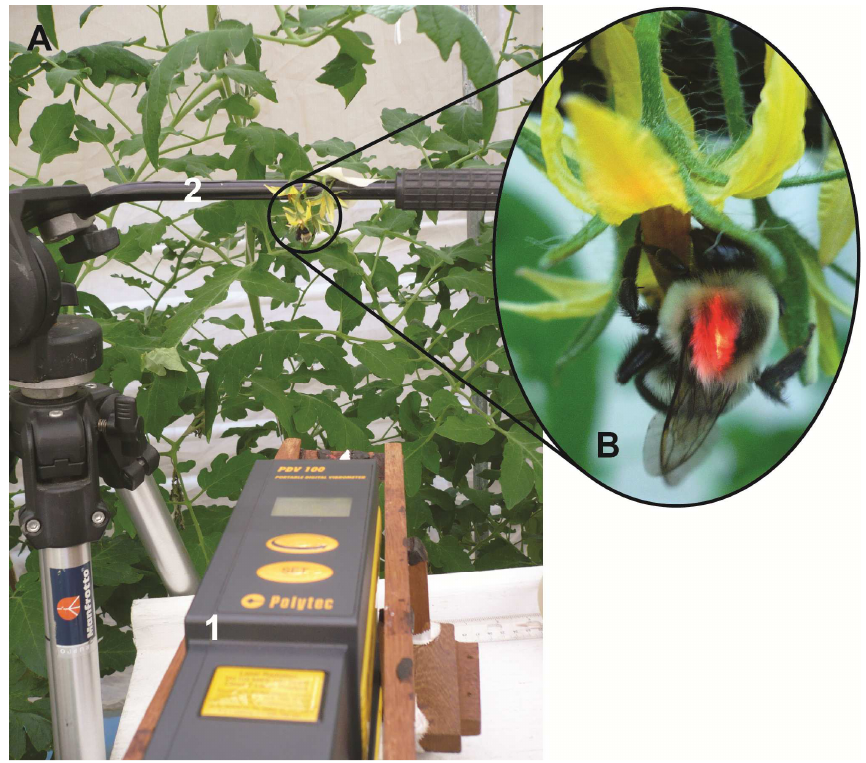
The setup showing the Laser Doppler Vibrometer mounted on a small four- wheeled cart (1) and the flower fixed to a tripod pan handle with adhesive tape (2) being visited by a forager. (B) The red dot on the scutum of the bee is the laser beam of the